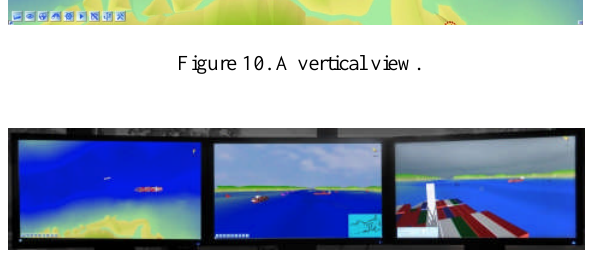
Figure 11. A three-screen control display, showing different live